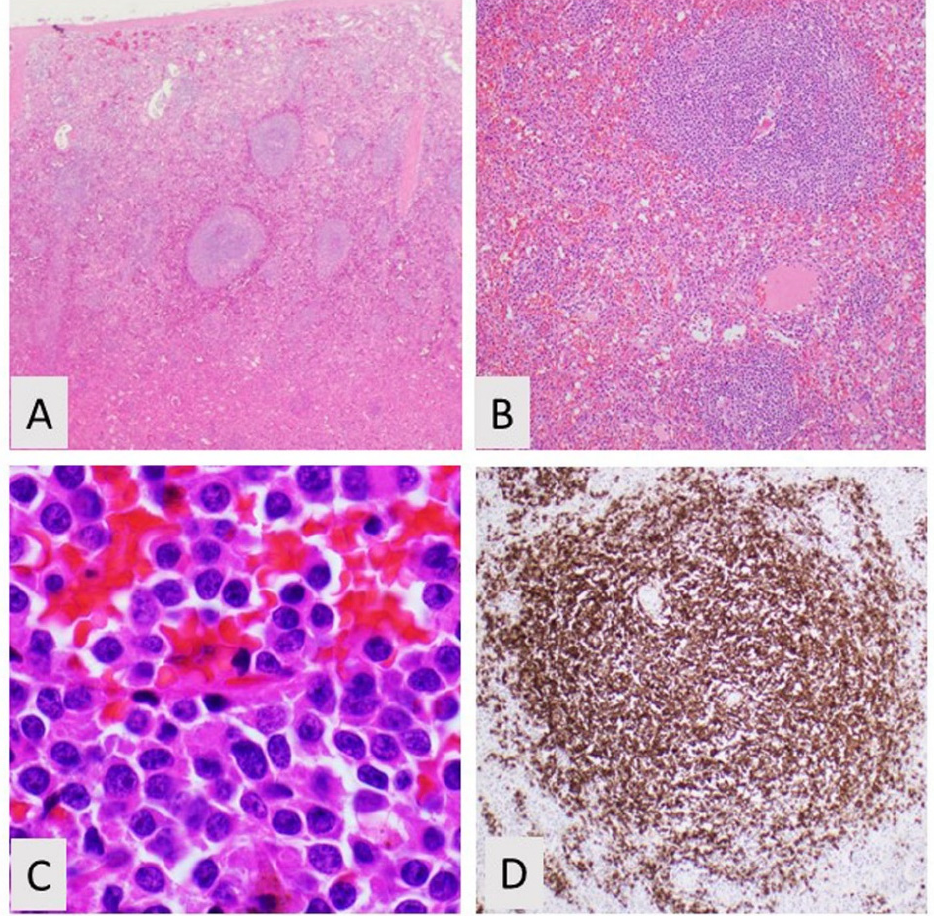
Figure 1. Splenic marginal zone lymphoma. ( A ) Low power of spleen with prominent follicles, H&E, 20 × ; ( B ) Atypical follicle comprised of small lymphocytes, H&E, 100 × ; ( C ) High power of plasmacytic lymphocytes, H&E, 400 × ; ( D ) Immunohistochemistry showing CD20 positivity. CD5 and CD10 are negative (not shown).